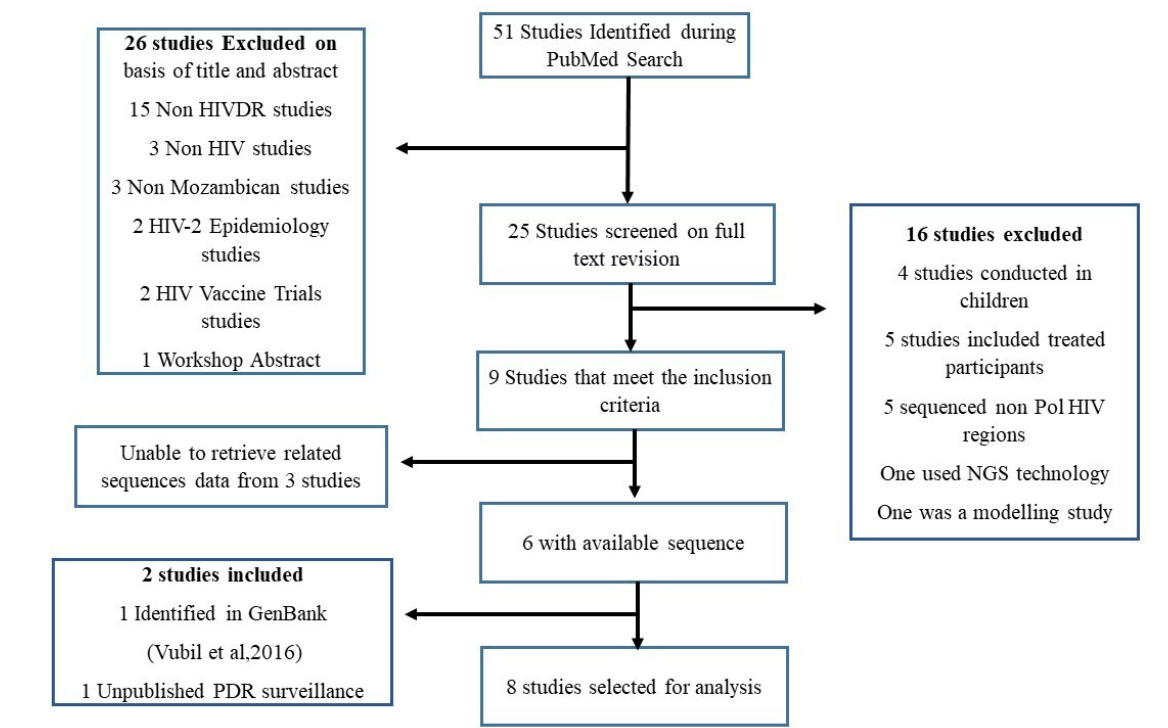
Figure 1. The flow diagram scheme of the literature research used to construct the dataset: NGS; Next Generation Sequencing, pol -Polymerase.